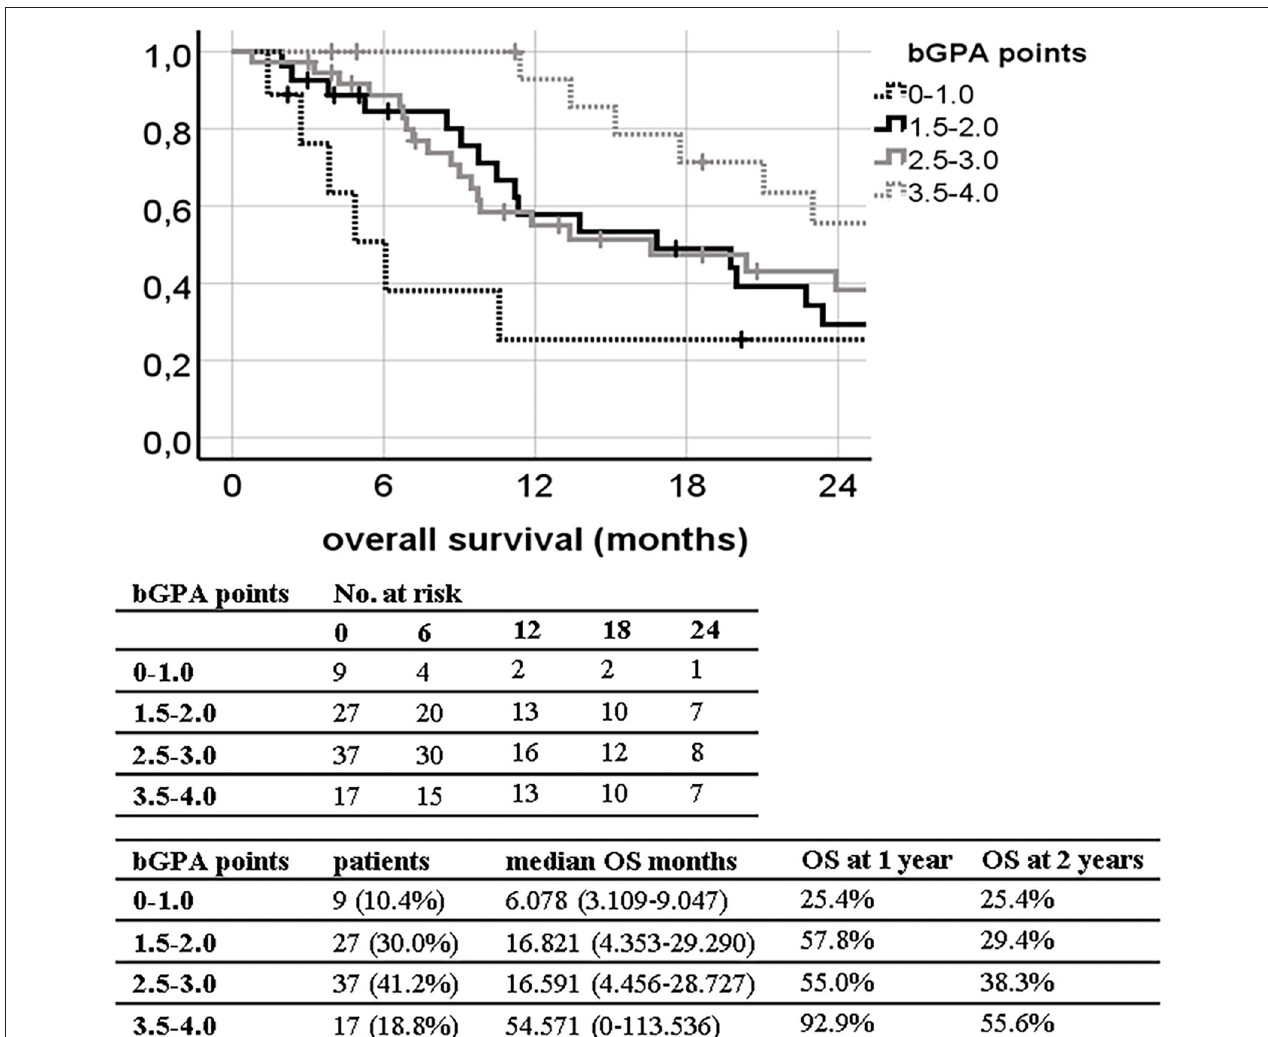
FIGURE 1 | Kaplan–Meier curves for overall survival (OS) divided by the breast graded prognostic assessment (bGPA) in our patient population (log-rank p = 0.030; concordance index 0.631; 95% CI, 0.514–0.748; p = 0.037) with median OS and 1- and 2-year OS estimates.